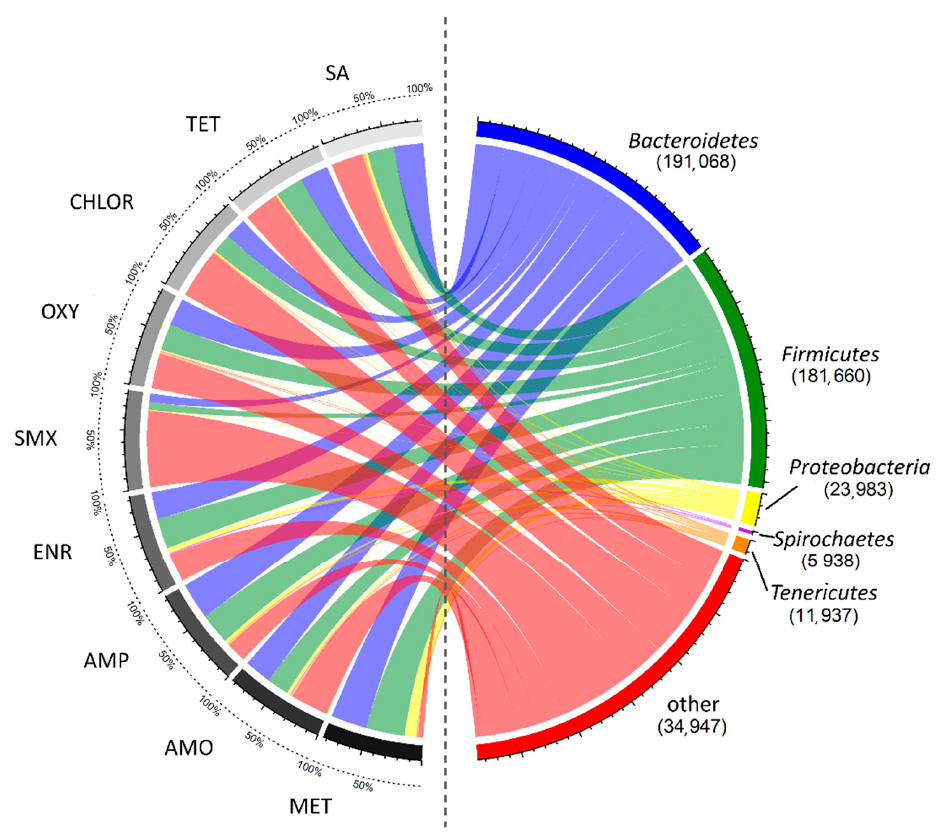
Figure 1. The taxonomic distribution of bacterial diversity as percentage values at the phylum level in digestate. Data visualised in Circos, where on the left is the percentage of microorganisms in the bioreactor and on the right is the sum of sequencing readings for a particular bioreactor.